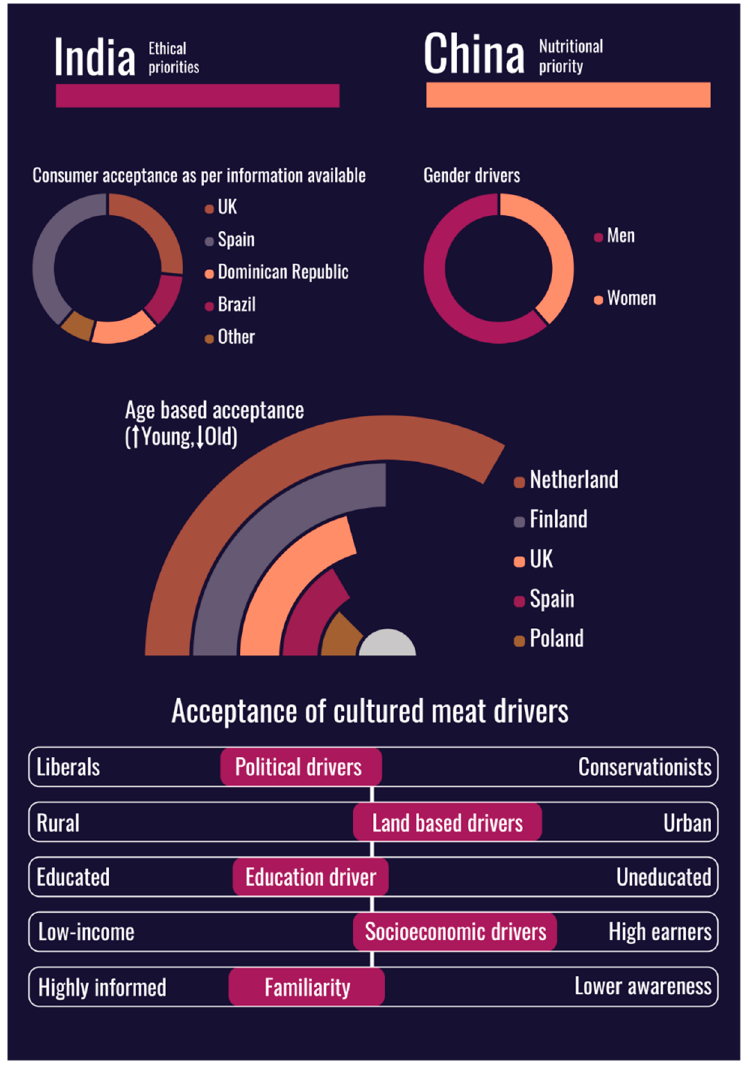
Figure 2. Consumer acceptance of CUME by country.